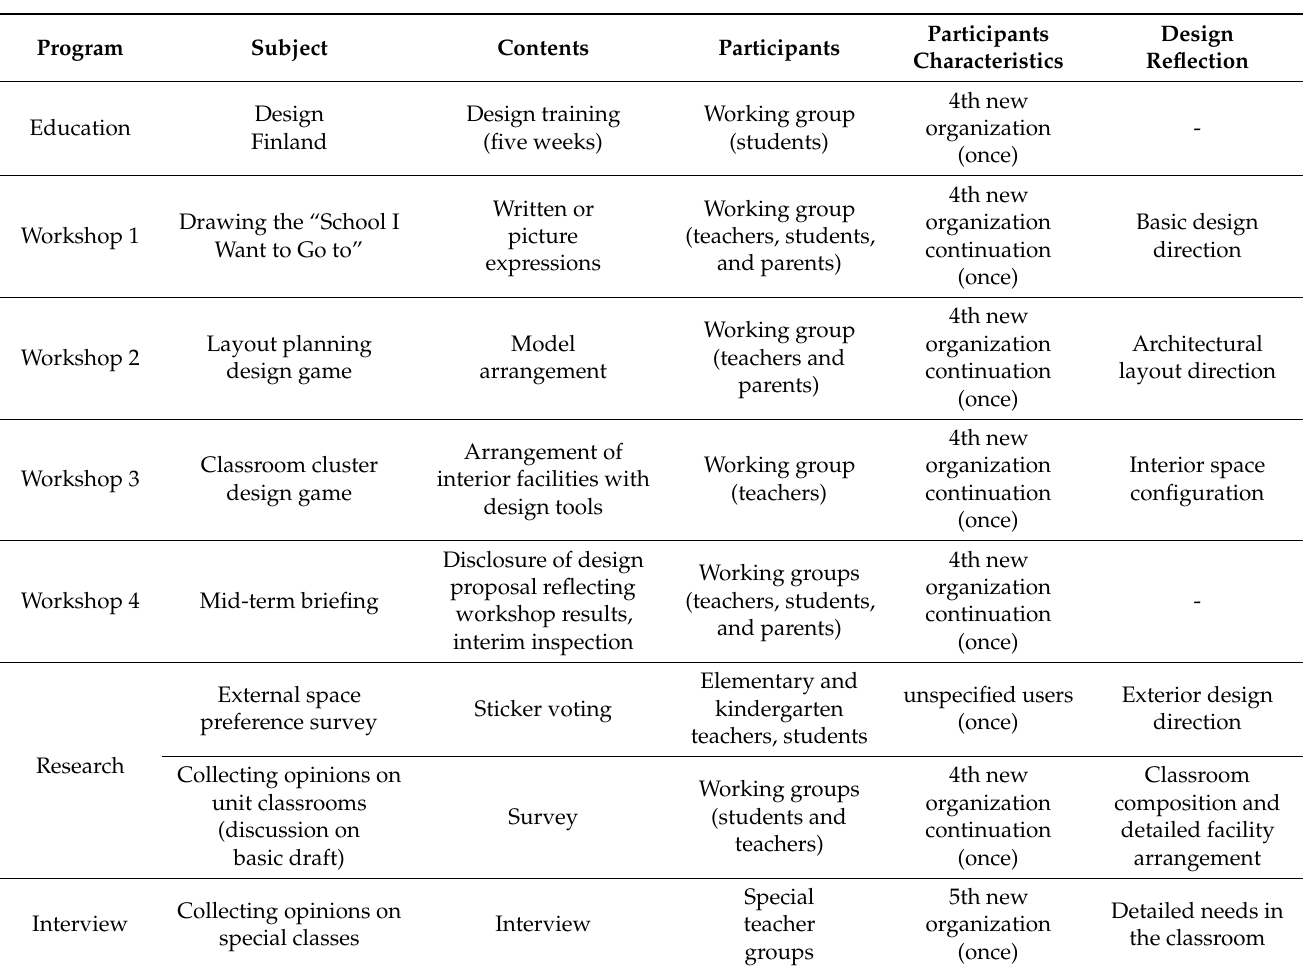
Table 4. User participation in the design process of the SEES project (chronological order) (Source: [16] (p. 181); reproduced by the